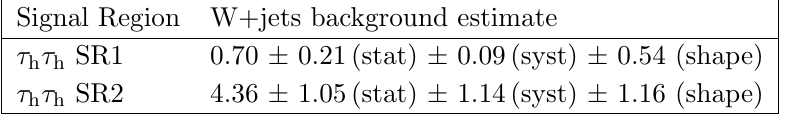
Table 3 . The W+jets background estimate in the two search regions. The systematic uncertainty \syst" comes from the maximum variation of the estimation found from varying the (cid:28) h energy scale within its uncertainty. The \shape" uncertainty takes into account the di(cid:11)erence between the shape of the search variable distribution in data and